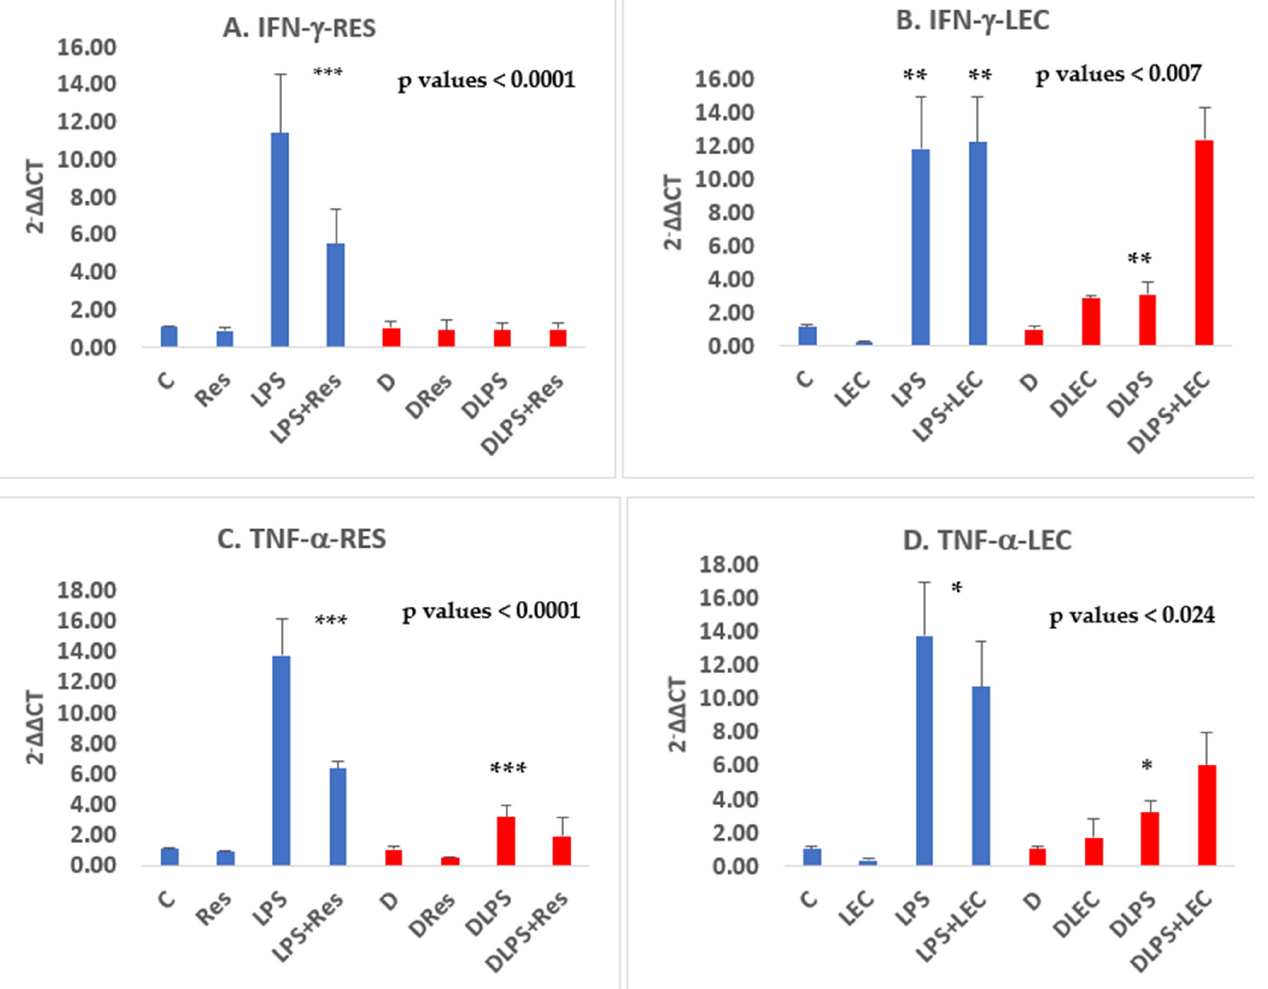
Figure 8. PBMCs were treated with either vehicle, RES, LPS, LPS + RES, or LEC10. RNA was extracted from cells and gene expression of IFN- γ and TNF- α was analyzed using qRT-PCR. Mean ± SEM. In these graphs, C, non-diabetic control was used to calculate 2 −ΔΔ CT for non-diabetics, and D control was used for diabetics. LPS did not induce gene expression of IFN- γ as robustly in PBMCs from PwD2, compared to non-diabetic controls. Values in a column sharing a common asterisk with proteasome modulators were significantly different at *, **, *** p < 0.024, 0.007, 0.0001, using 1-way Anova. 2 - ΔΔ CT = Relative quantification RQ. (Experiments 1–4 are described in the Methods section).